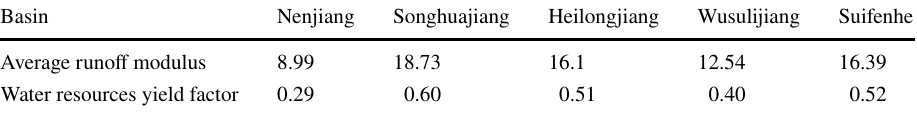
Table 3 Water yield factor of each basin